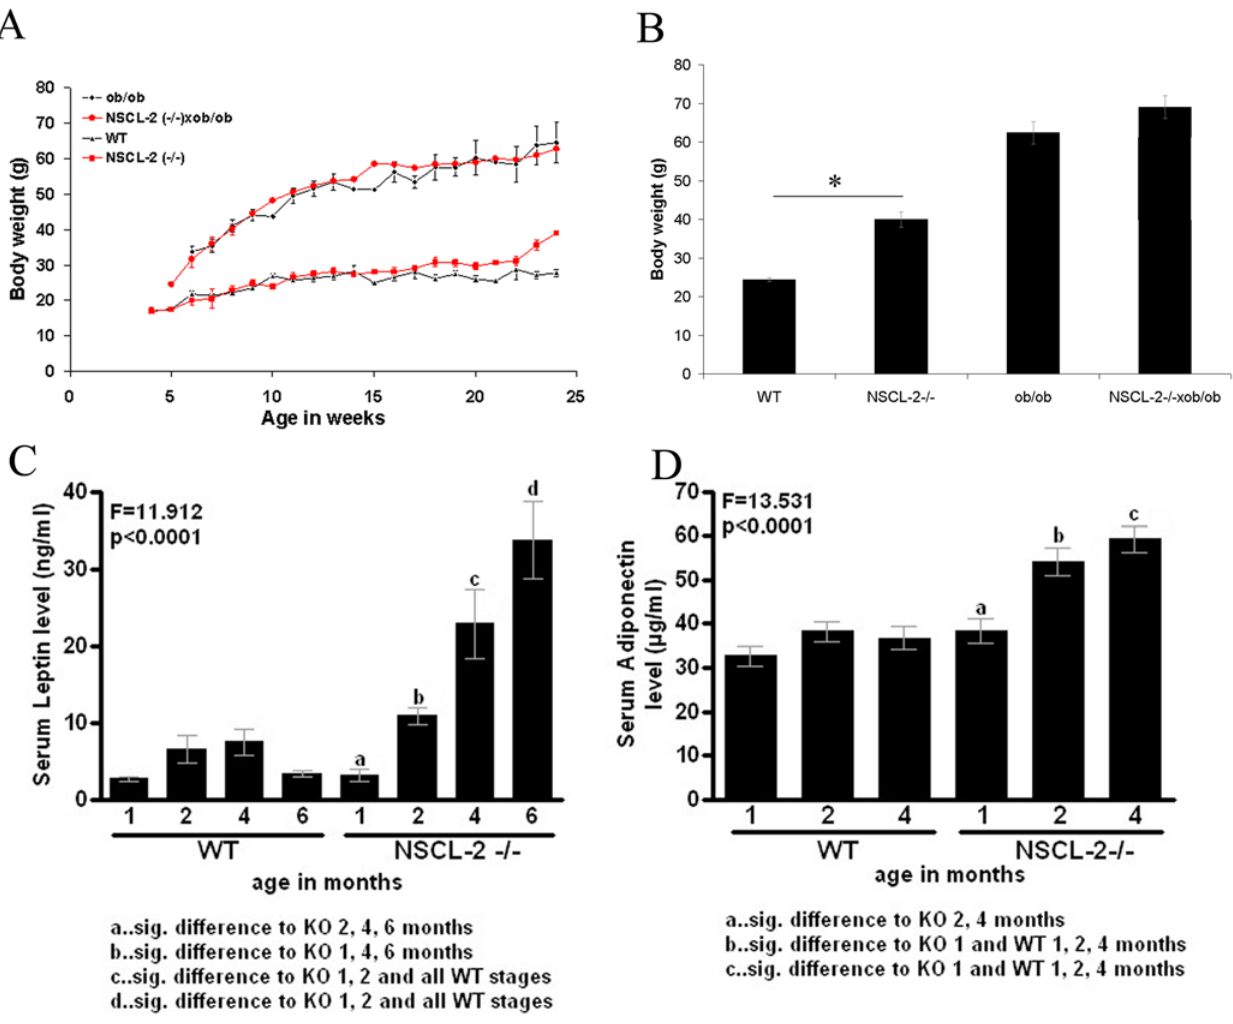
Figure 3. Increased expression of leptin precedes abnormal gain of weight in Nscl-2 mutant mice. (A) Significant differences in the body weight of WT and Nscl-2 ( 2 / 2 ) mice occur only post-puberty after 12–15 weeks of age (lower two graphs). Nscl-2 ( 2 / 2 ) 6 ob/ob and ob/ob mutant mice show a similar increase of body weight during postnatal growth (upper two graphs). (B) Body weight of 6–8 month old Nscl-2 ( 2 / 2 ), Nscl-2 ( 2 / 2 ) 6 ob/ob, ob/ob, and wild type male mice (F=53.33; dF=3; p , 10 2 4 ). (C) Serum leptin levels are massively elevated in Nscl-2 ( 2 / 2 ) mice at 2, 4 and 6 month (F=11.91; dF=7; p , 0.001). Note that the increase of serum levels of leptin in Nscl-2 mutant mice precedes the abnormal gain of weight. (D) Serum adiponectin levels are elevated in Nscl-2 ( 2 / 2 ) mice at 2, and 4 month compared to wildtype control animals (F=13.53; dF=7; p ,